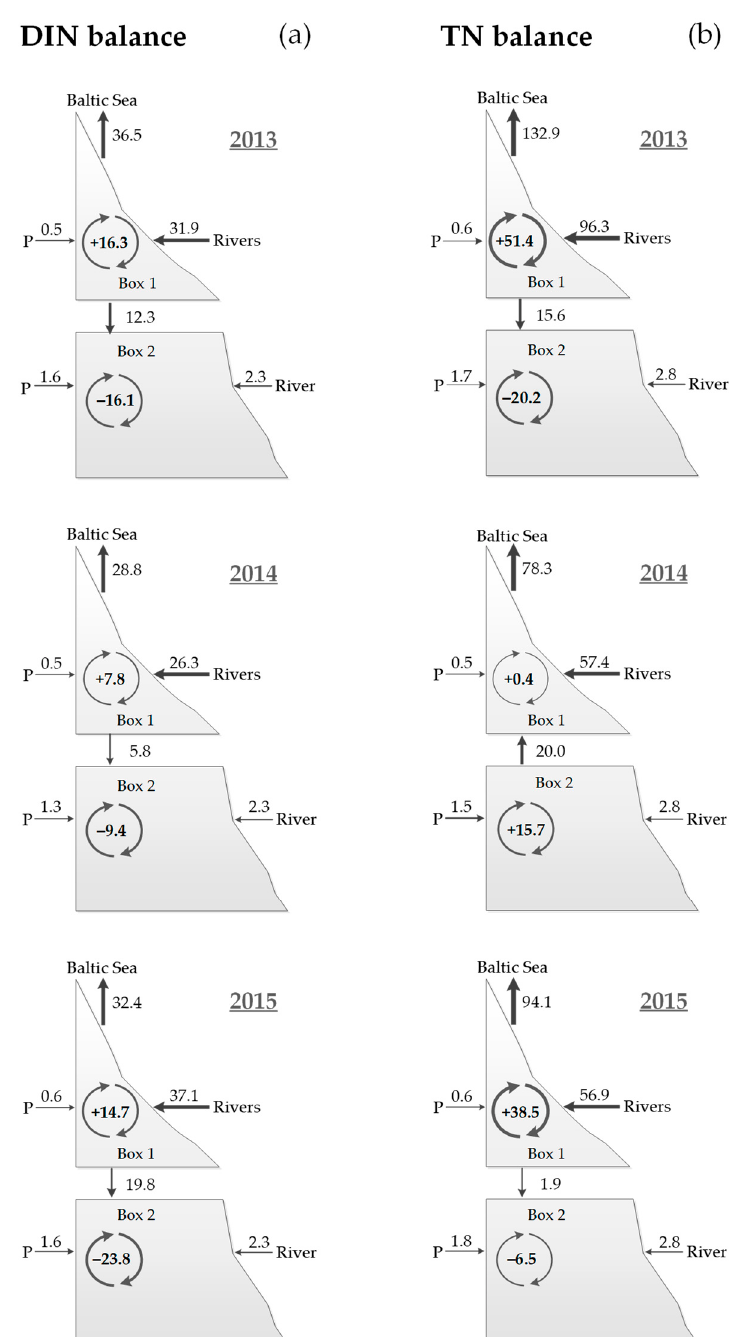
Figure 4. Dissolved inorganic (DIN) ( a ) and total nitrogen (TN) ( b ) balance for the Curonian Lagoon in 2013–2015. Legends are the same of Figure 3. Units are 10 5 mol d − 1 .